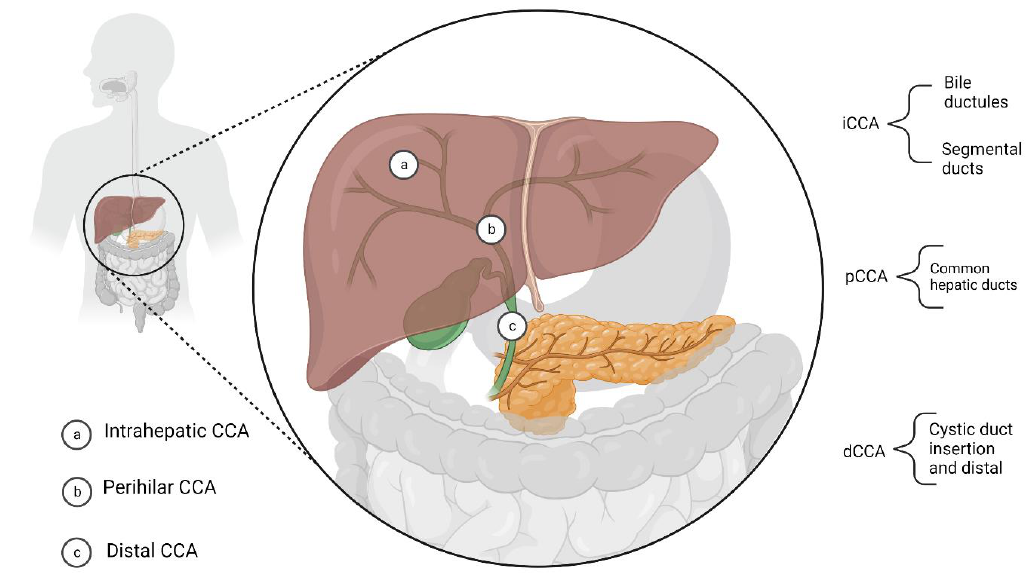
Figure 1. Anatomical division of cholangiocarcinoma (CCA).